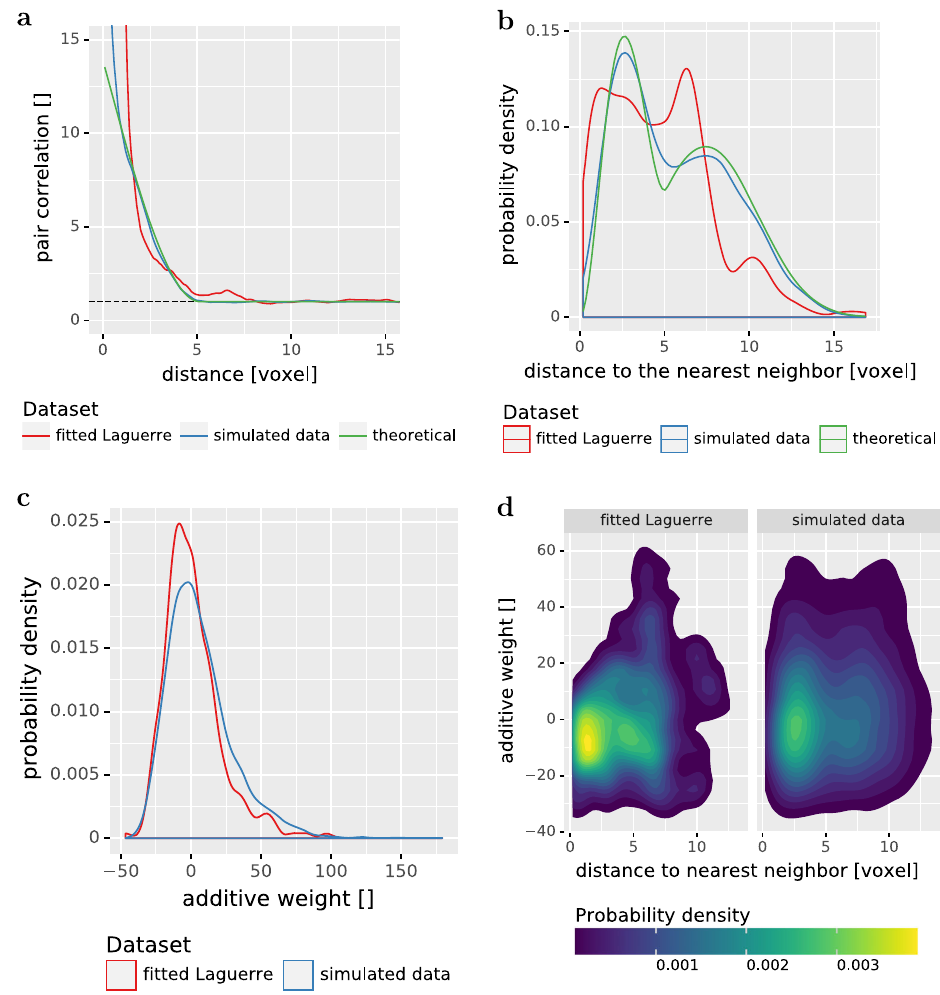
Fig. 6 Calibration of the grain architecture model. Comparison of characteristics of the Laguerre tessellation fi tted to FIB-EBSD data and the stochastic grain architecture model. Pair correlation function of seed points ( a ), probability densities of nearest neighbor distances ( b ) and additive weights ( c ), and two-dimensional (joint) density of additive weights and nearest neighbor distances of seed points ( d ). All distances are given in terms of the voxel length scale of FIB-EBSD